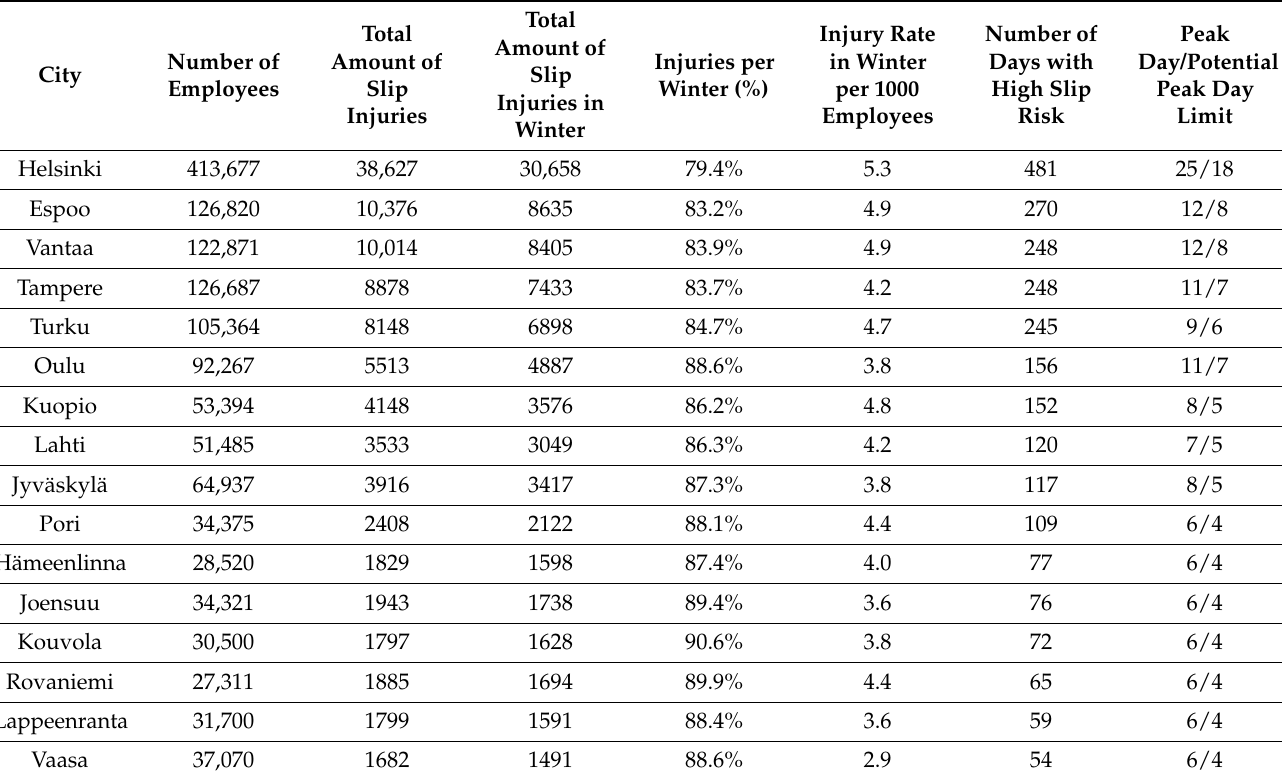
Table 1. Information of the cities including the number of employees [37], amounts of slips, injury rate in winter, number of days with high slip rate and thresholds for peak day and potential peak day during 2005–2019 based on the TVK’s slip injury